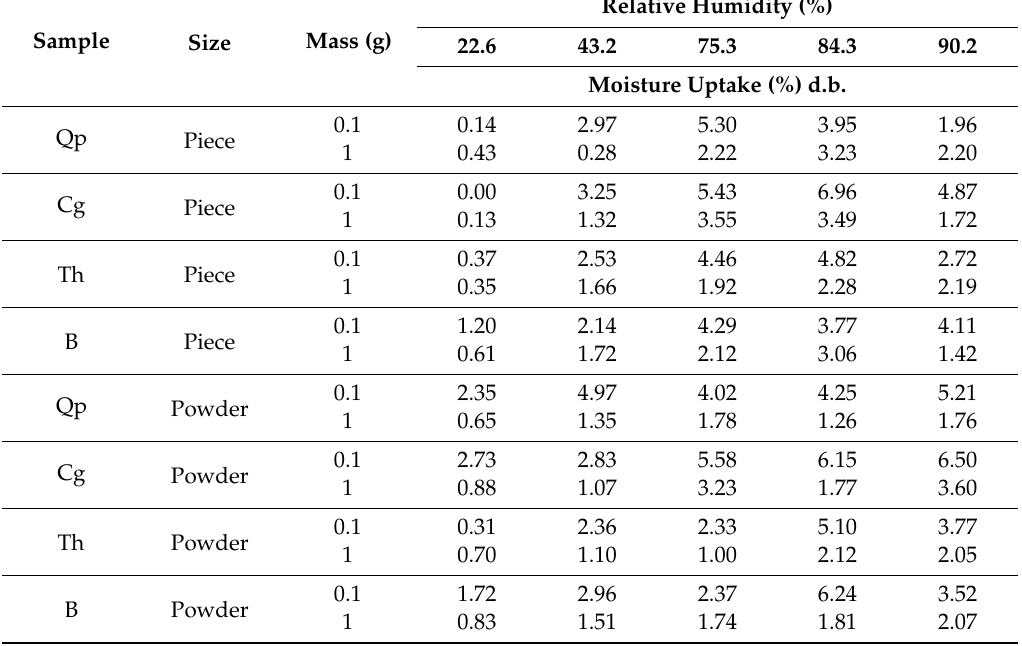
Table 3. Averaged values for water adsorption (%) from pieces and powdered biochars exposed to different relative humidities of air based on a random factorial design, considering two replicates per test. (d.b. = dry